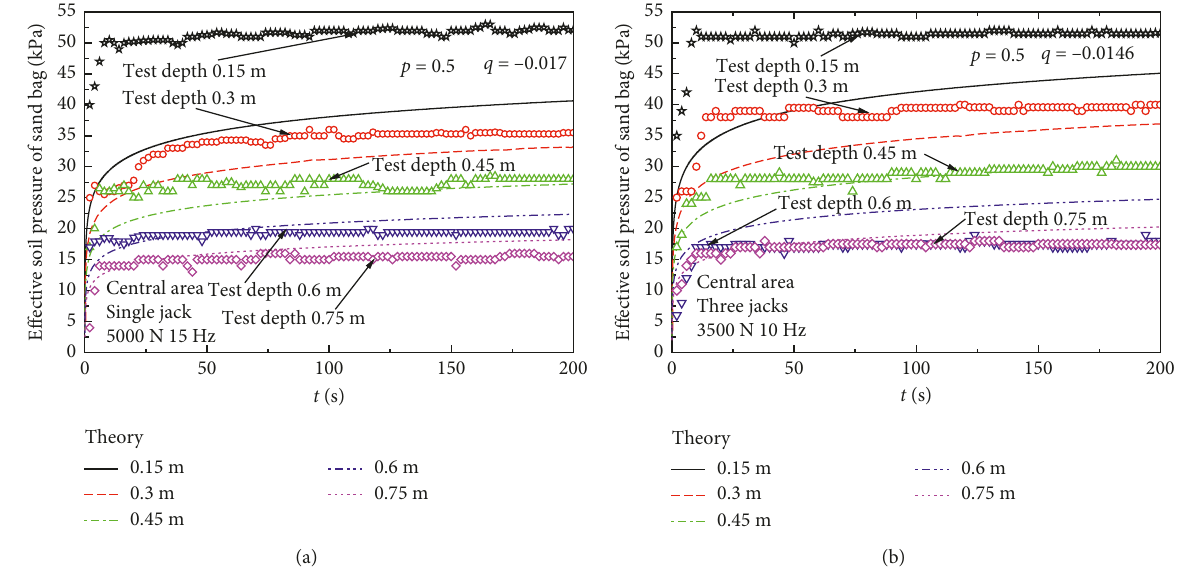
Figure 11: Variation in the effective soil pressure versus time curve at different measurement points (sand bag): (a) single jack and (b) three jacks.